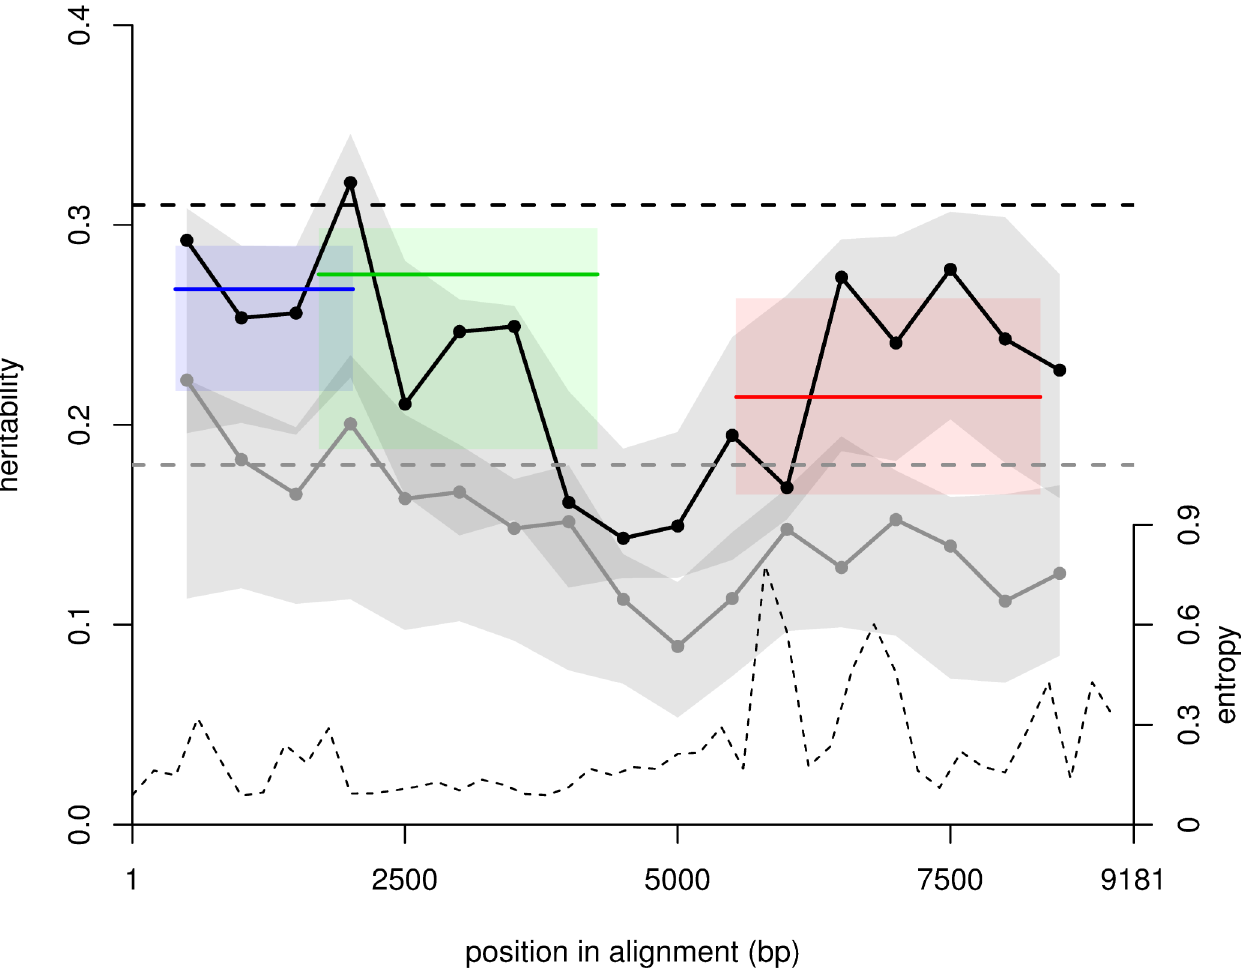
Fig 3. Maximum likelihood estimates of heritability across the genome. Heritabilitywas inferred for overlappingwindowsof 1,000 bp separated by 500 bp for the Ornstein–Uhlenbeck(OU) model (black bullets) and the Brownian motion (BM) model (grey bullets). The horizontal dashedlines are the whole-genomeheritabilityestimates. The 3 colored segmentsshow heritabilityfor gag , pol , and env genes in blue, green, red (for OU only). Confidenceintervals (grey and colored regions) reflect phylogenetic uncertainty. The largest heritabilityis in the regionwhere gag and pol overlap. We also show entropy—a measureof geneticdiversity—along the genome(dashedcurve and right axis). Entropy at a position was calculatedas −Σ i 2 { A , C , G , T } p i log( p i ), and we show the averageentropy over 200-bpwindows. The data used in the figure are providedas S1 Data.